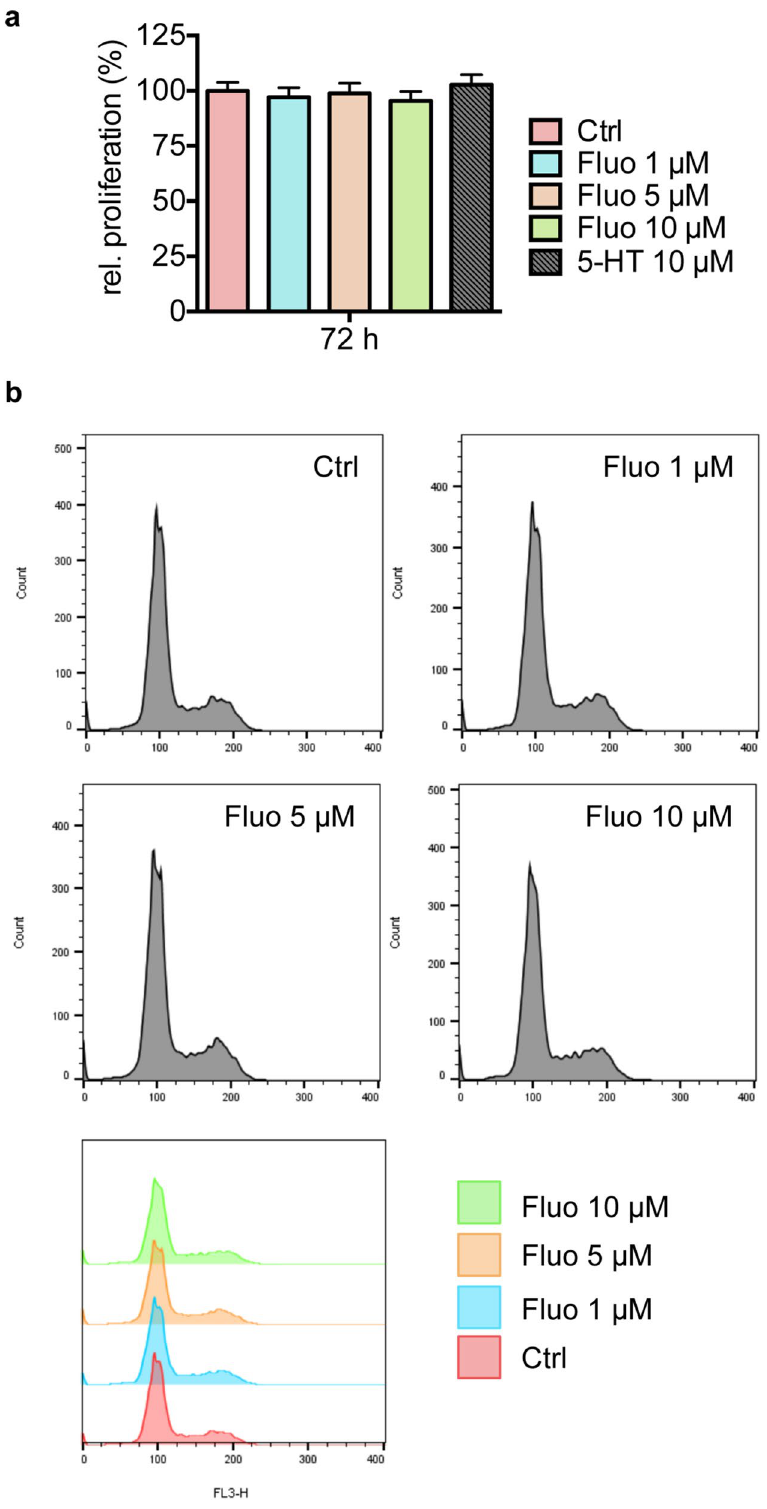
Figure 3. Higher concentrations of fluoxetine have no significant impact on proliferation and cell cycle progression of MDA-MB-231 breast cancer cells. ( a ) Bar graph depicts relative proliferation of MDA-MB-231 breast cancer cells in response to 72 h stimulation with 1 µM, 5 µM or 10 µM fluoxetine (Fluo) compared to treatment with 10 µM 5-HT or corresponding DMSO-treated control cells (Ctrl) as assessed by Fluoroskan. ( b ) Histograms depict representative results of cell cycle analysis of MDA-MB-231 cells in response to fluoxetine (Fluo) stimulation with indicated concentrations for 72 h. Data in ( a ) derive from n = 10 experiments and are depicted as means ± SEM. P -values were computed by one-way ANOVA followed by Dunnett’s multiple comparison